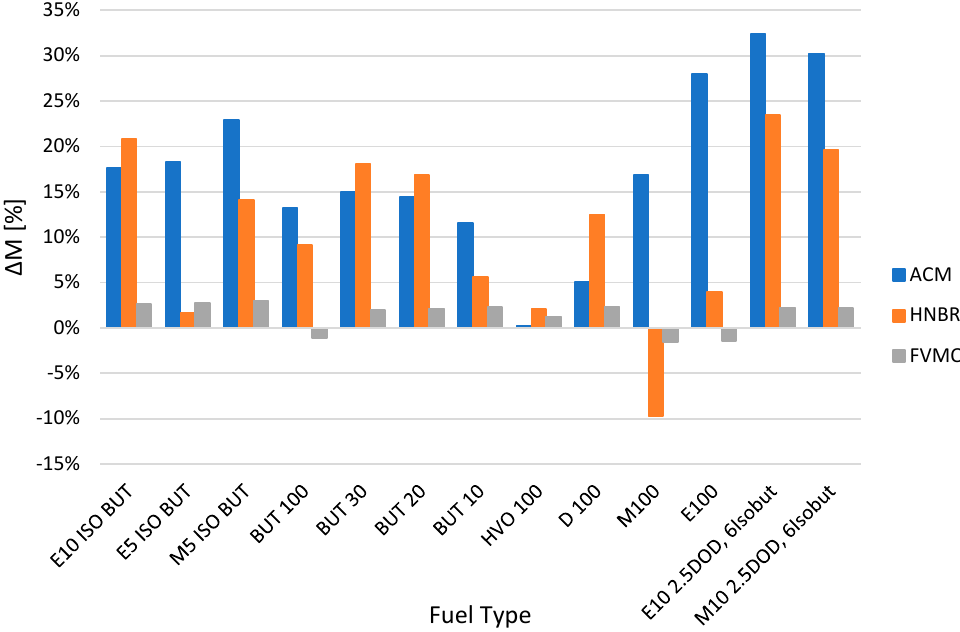
Figure 2. Change in mass Δ M for different elastomer O-rings and fuels after exposure for a time interval of 2998 h.